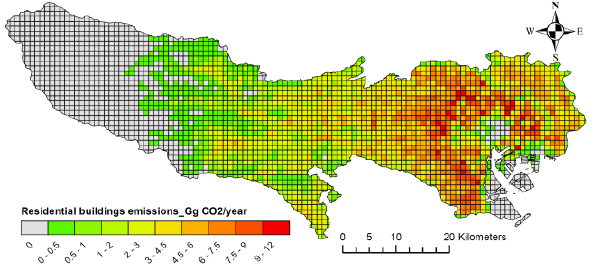
Figure 7. CO 2 maps on emissions from residential buildings of Tokyo in 2014, unit: Gg CO 2 grid -1 yr -1